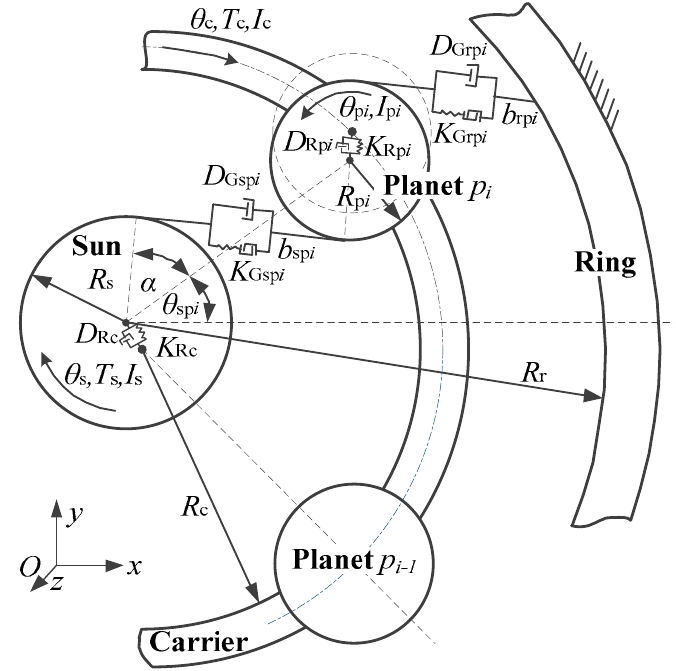
Figure 3. Joint dynamics model of planetary gear transmission.